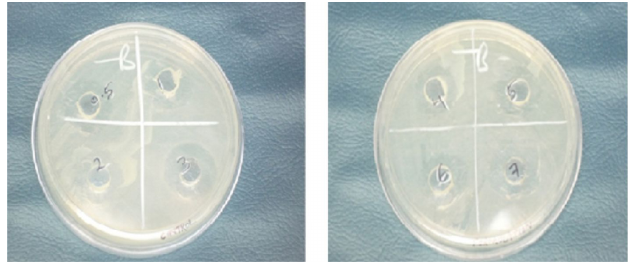
FIGURE 9 - The pictures depicting zone of inhibition of samples obtained from in vitro drug release study of time-dependent release bilayer tablet formulation (F2) of AMT in E. coli .